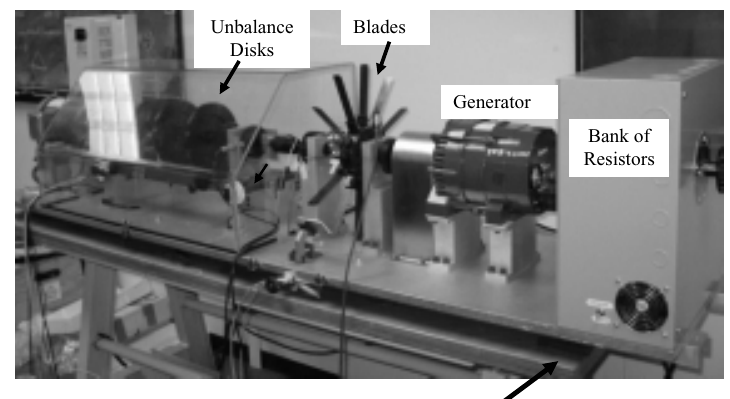
Fig. 24. Schematic of the test-rig.